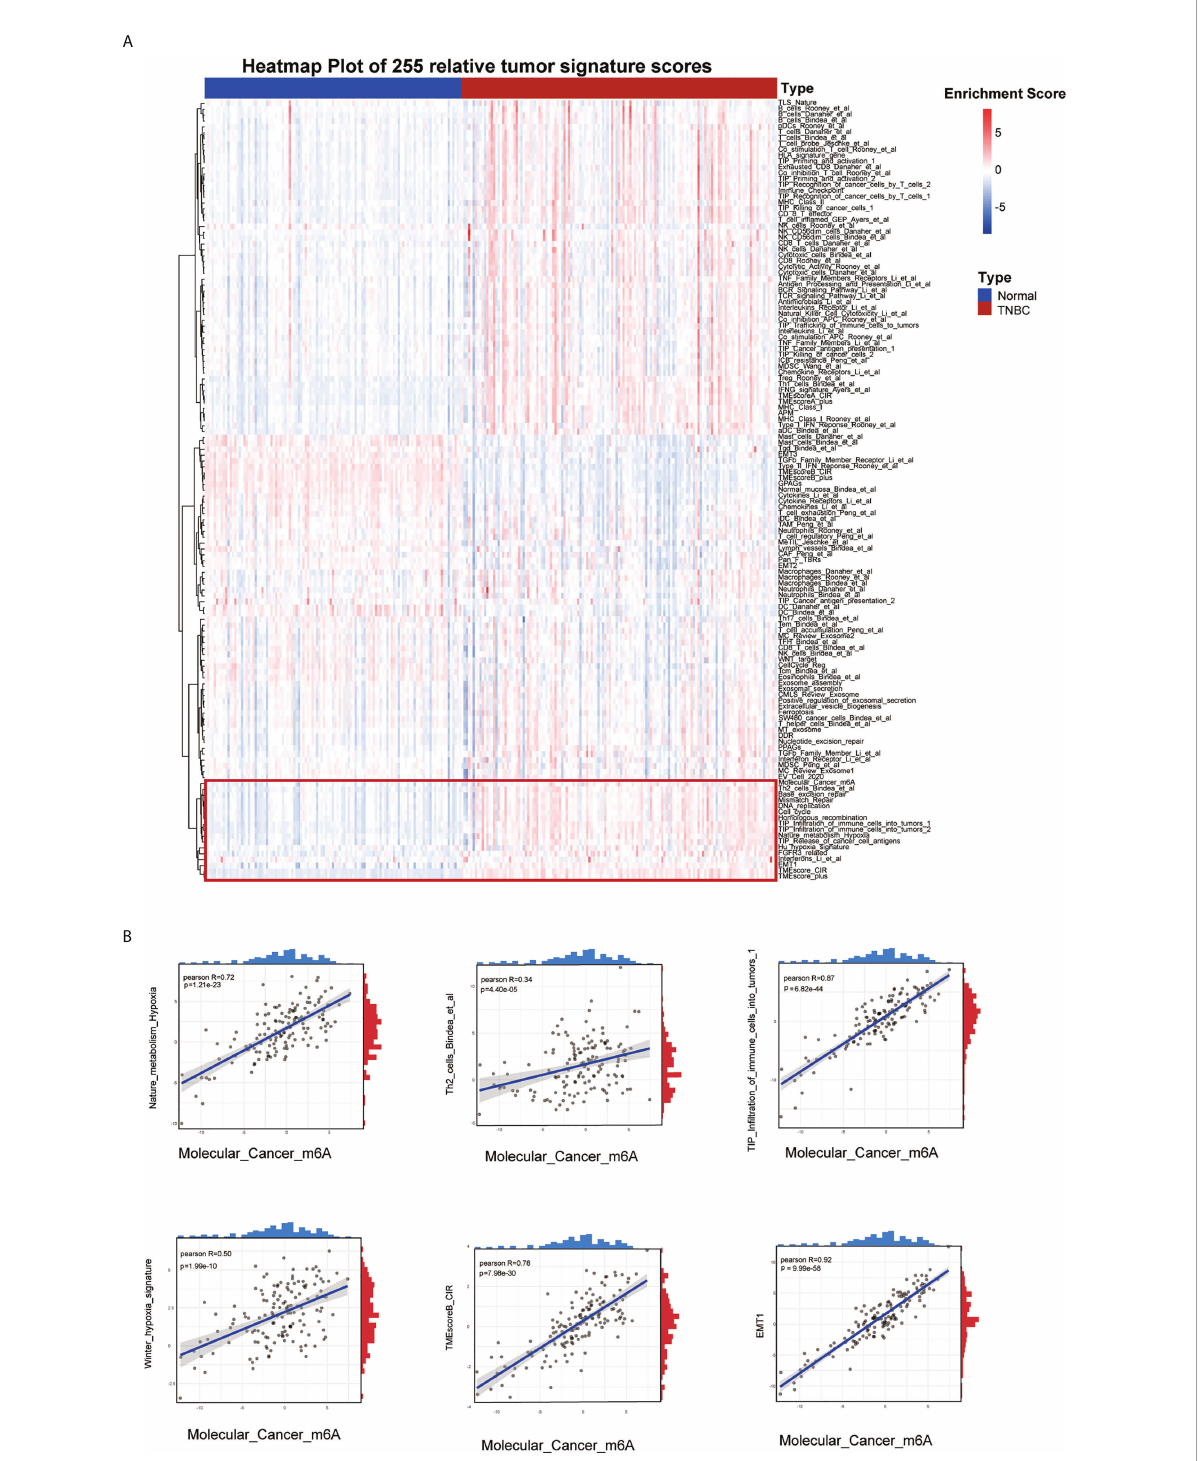
FIGURE 2 Landscape of tumor relative signatures in triple-negative breast cancer. (A) The heatmap of 255 tumor relative signatures score of 139 TNBC cases and 114 normal cases from TCGA. (B) The positive correlation between Molecular_Cancer_m6A and Nature_metabolism_Hypoxia, Winter_hypoxia_signature, Th2_cells_Bindea_et_al, TMEscoreB_CIR, Tip_In fi ltration_of_immune_cells_into_tumors_1 and